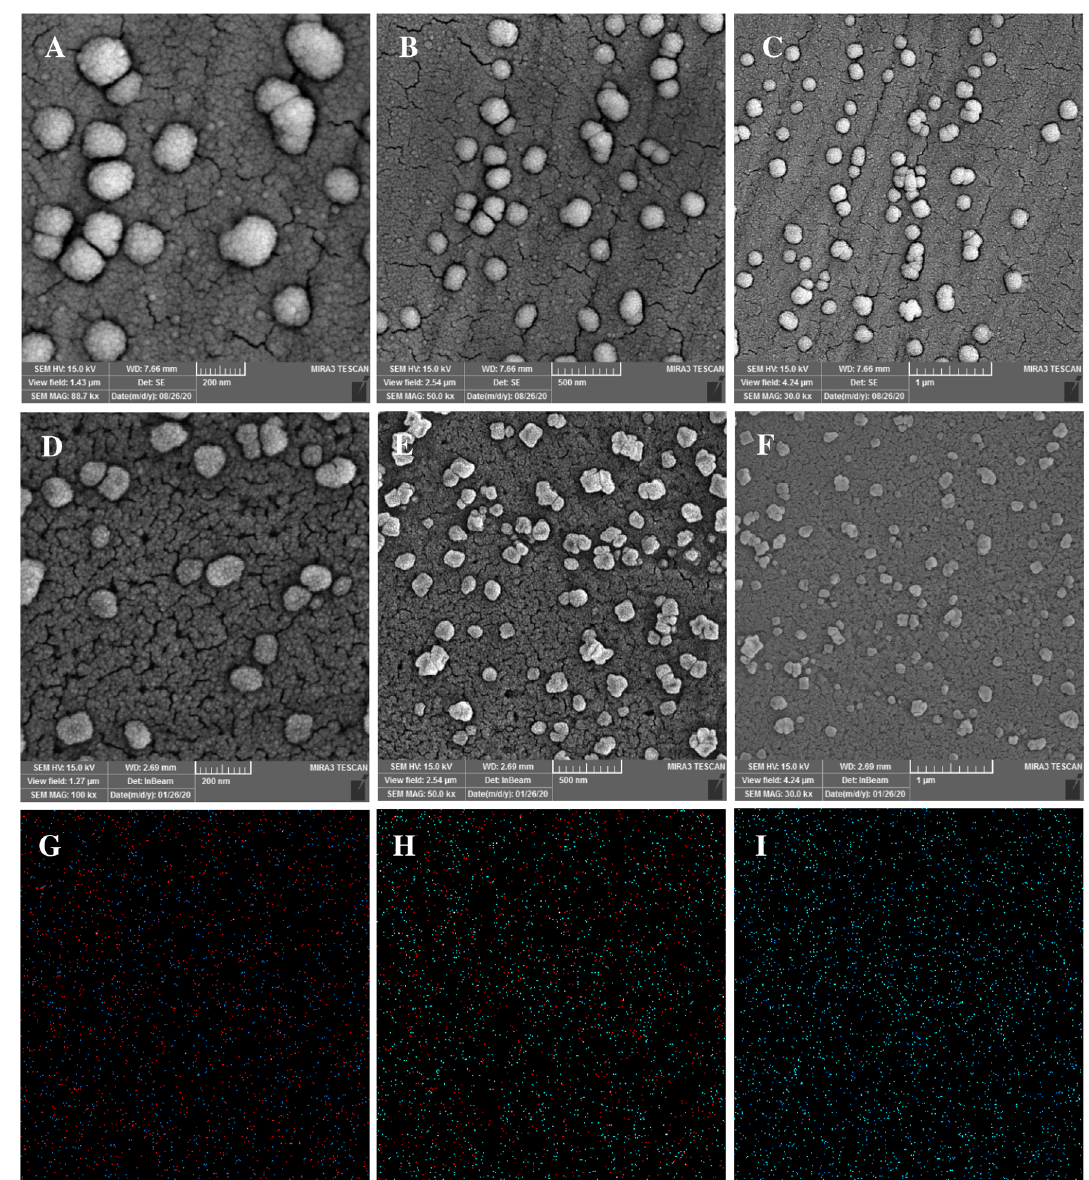
Figure 4. The SEM images of WO 3 /p-Glu ( A – C ), WO 3 /p-Glu-EDC-NHS-Ab ( D – F ) at different scales and dot mapping results of WO3/p-Glu ( G – I